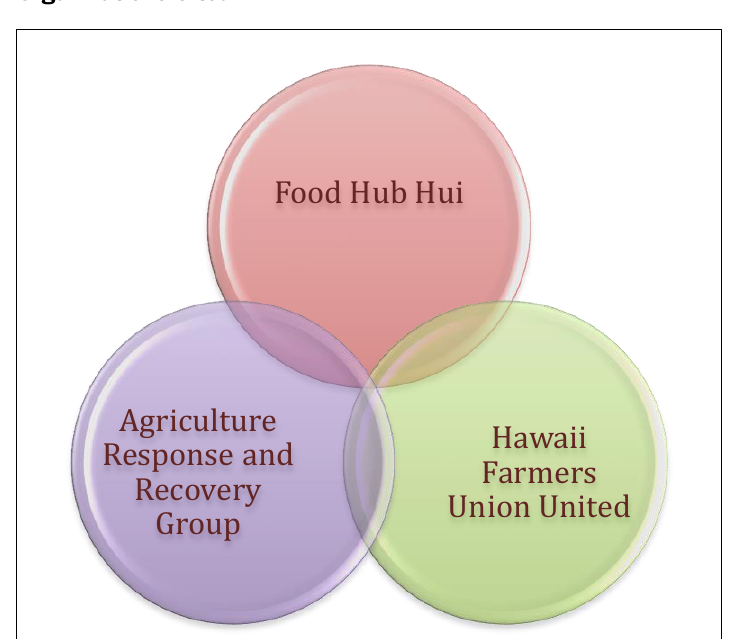
Figure 1. Venn Diagram of the Two Authors and the Organizations